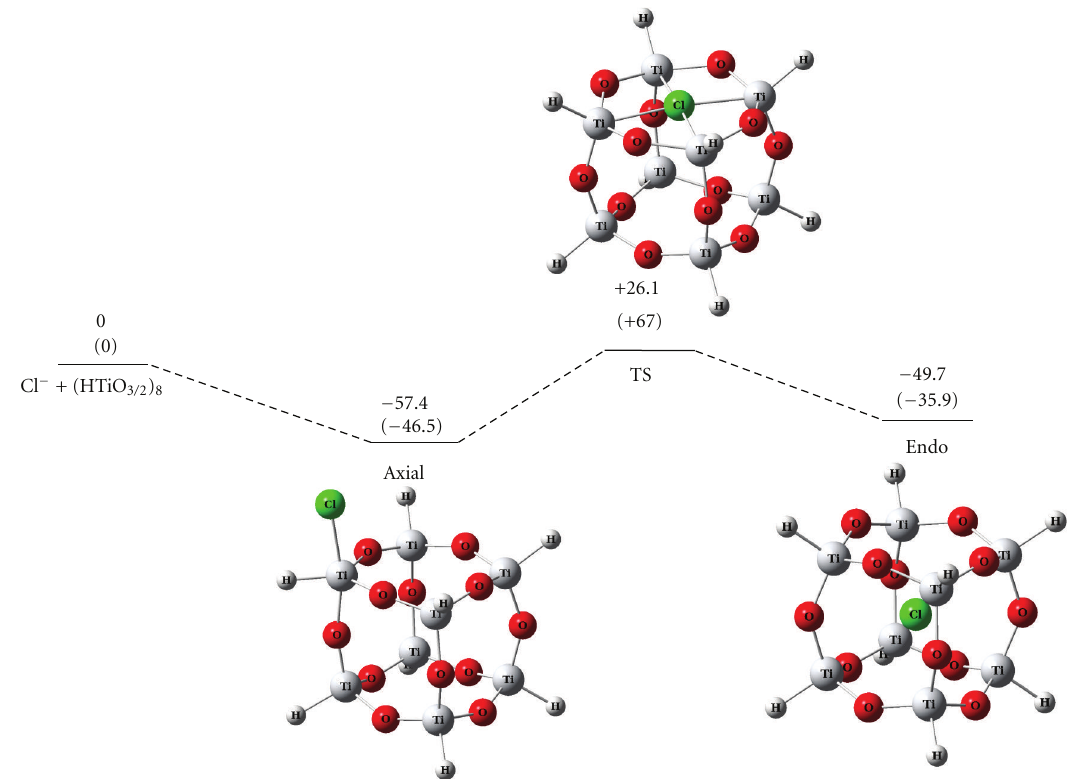
Figure 7: The potential energy surface (kcal/mol) of the insertion reaction of Cl − into Ti-T 8 with the structures of the exohedral (Axial) and endohedral (Endo) complexes and the transition state (TS) connecting them at the B3LYP/6-311+G(d)+ZPC and HF/6-311+G(d)+ZPC (in parentheses)